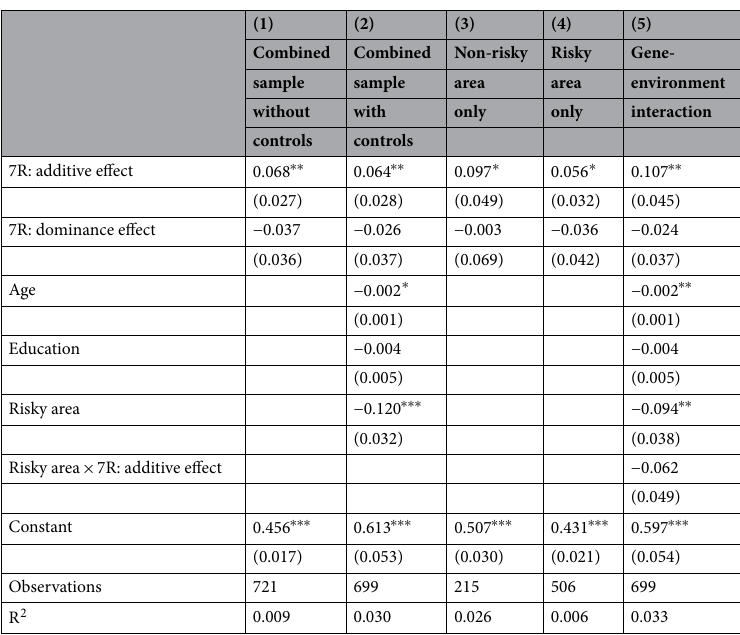
Table 2. Differences between genotypes in risk-tolerance. Note: The outcome variable is risk-tolerance. A higher level of risk-tolerance indicates the choice of a riskier lottery by participants in the lottery choice task. Standard errors in parentheses. The coefficients are the results of Ordinary Least Square (OLS) estimations. In column 1, the sample is pooled (non-risky and risky areas) and no control variable is included. In column 2, the sample is pooled and controls for age, education and a dummy for living in the risky area are included. In columns 3 and 4, the sample is restricted to individuals from the non-risky and risky areas, respectively. In column 5, we interact the additive effect of the 7R allele with the dummy variable for living in the risky area. Further details on the equation used in column 5 can be found in the Methods section. Student’s t -test * p < 0.10, ** p < 0.05, *** p < 0.01. To see the correlations between controls and risk-tolerance, absent any genetic factor, see Table